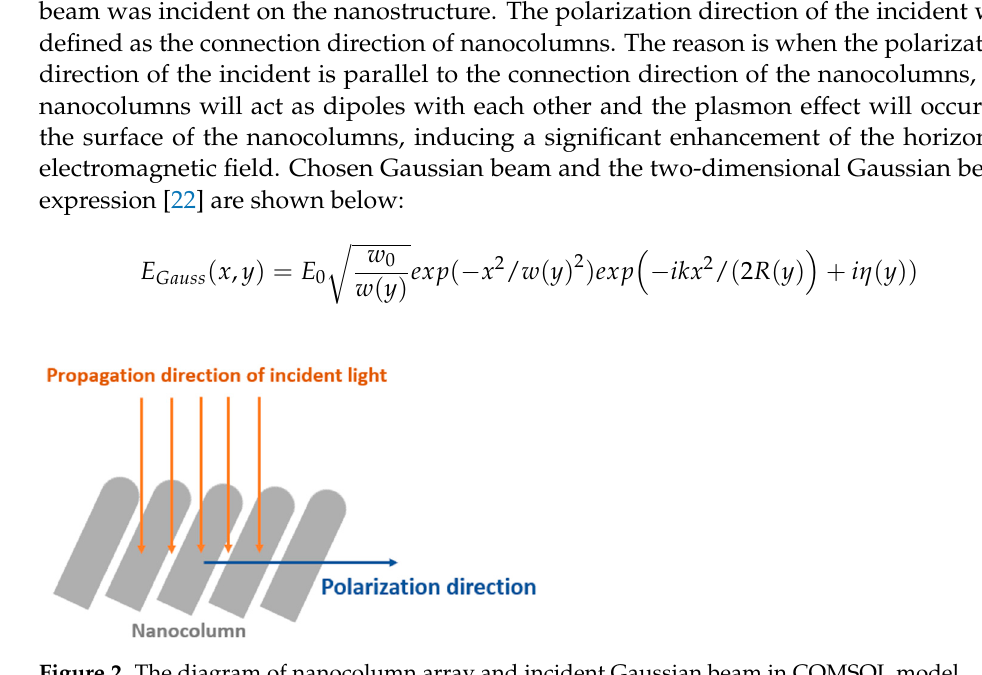
Figure 3. The configuration of OAD system.